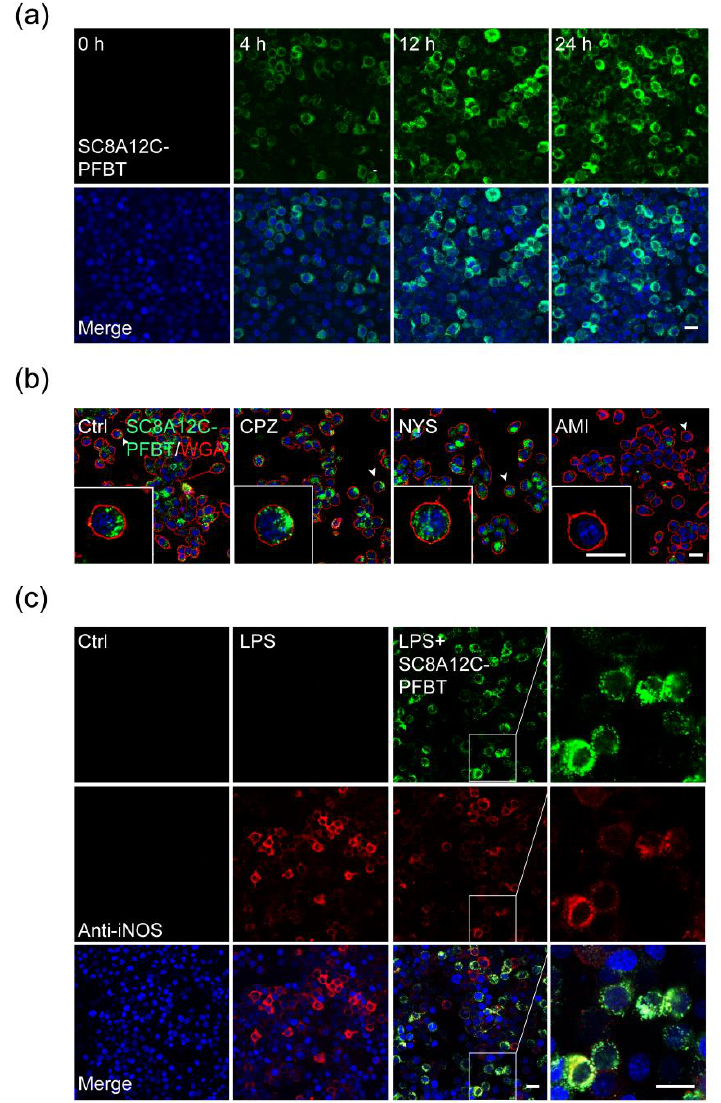
Figure 4. ( a ) Intracellular SC8A12C-PFBT (green) was observed in BV2 (treated with 25 µ g/mL) by fluorescence imaging. Scale bar, 10 µ m; ( b ) the images of SC8A12C assemblies’ internalization in BV2 cells with the treatment of CPZ (5 µ M), NYS (10 µ M), and AMI (0.01 µ M). Scale bar, 20 µ m; ( c ) colocalization detection of SC8A12C-PFBT (green) and iNOS (red). SC8A12C-PFBT located inflammatory cells and achieved an anti-inflammatory effect. Scale bar, 10 μm.